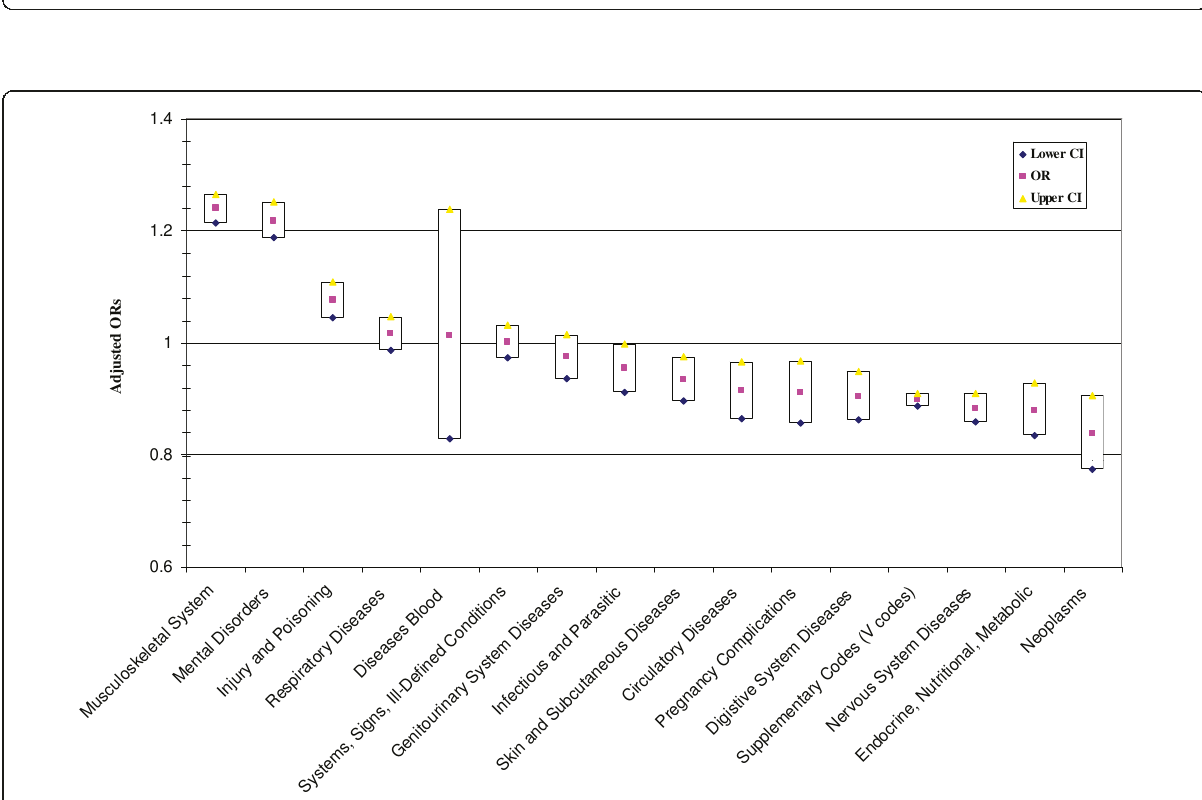
Figure 2 Adjusted odds ratios and 95% confidence intervals for odds of an outpatient visit for illnesses by CAM use versus non-CAM use, adjusted for sex, age, education, marital status, race/ethnicity, pay grade, branch of service, and occupation